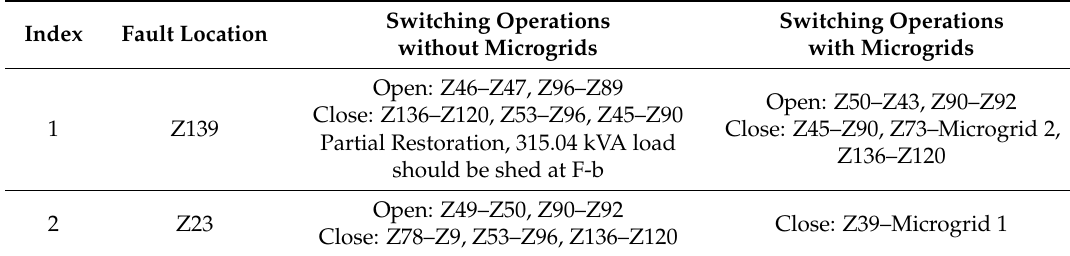
Table 1. Service restoration strategies proposed by spanning tree search algorithm.